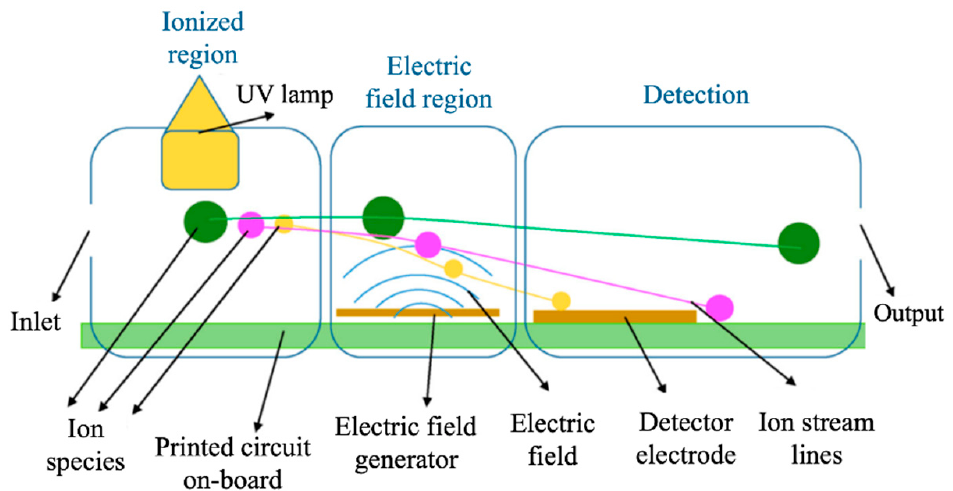
Figure 2. Schematic representation of different components in a PID optical gas sensor for the detection of different VOCs (color dots). Reprinted from ref [47]. Copyright 2018, Elsevier.